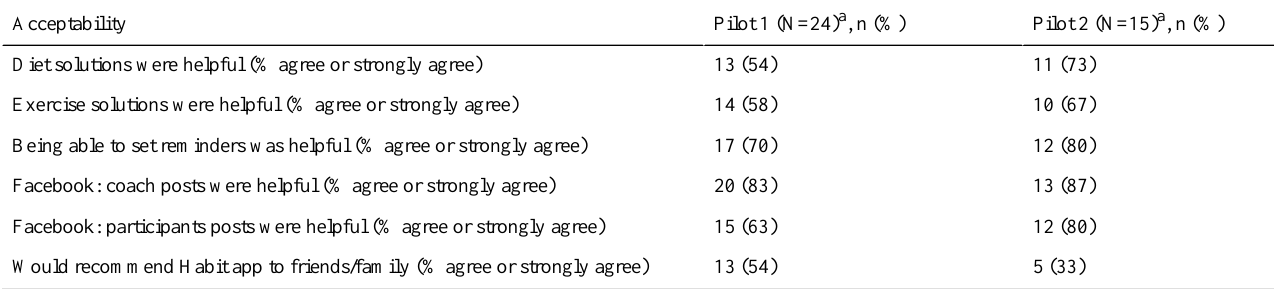
Table 5. Acceptability of the Habit app in pilots 1 and